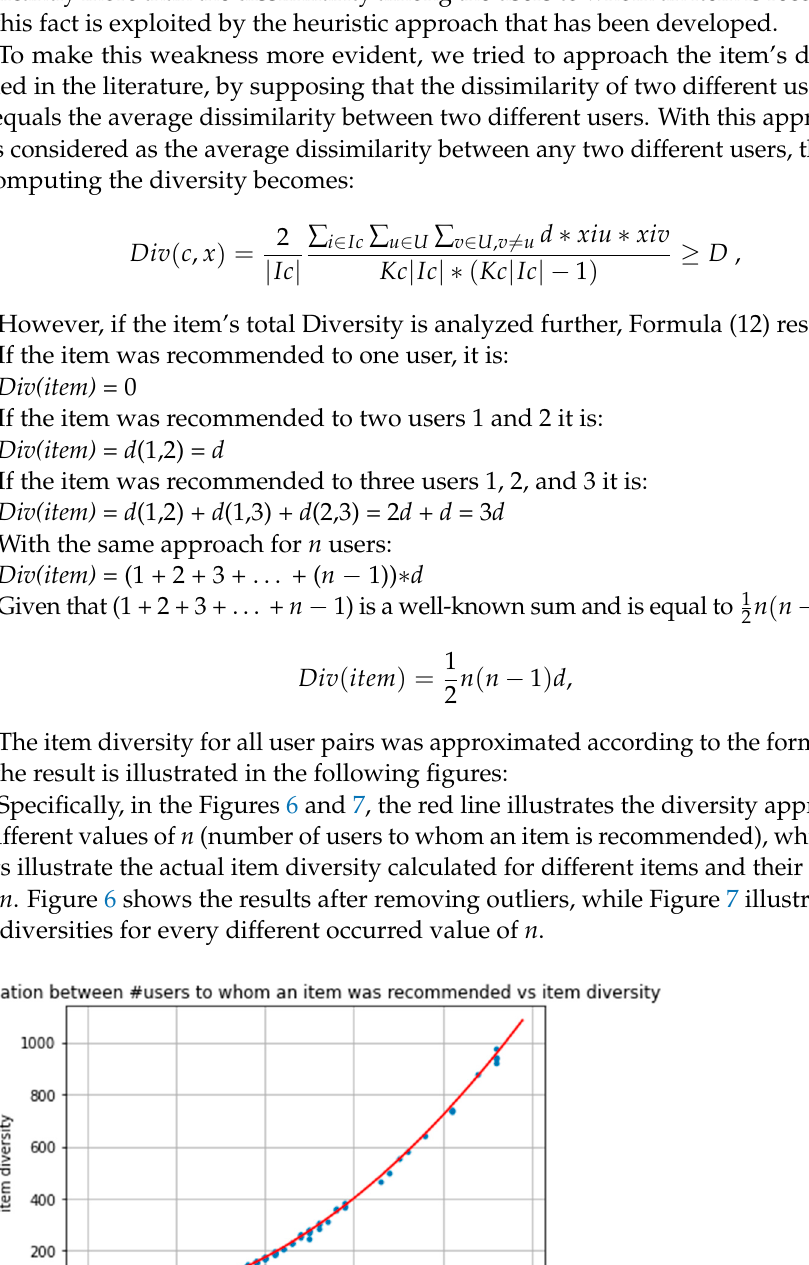
Figure 7. Relation between item diversity and number of users to whom the items were recom ‐ mended.